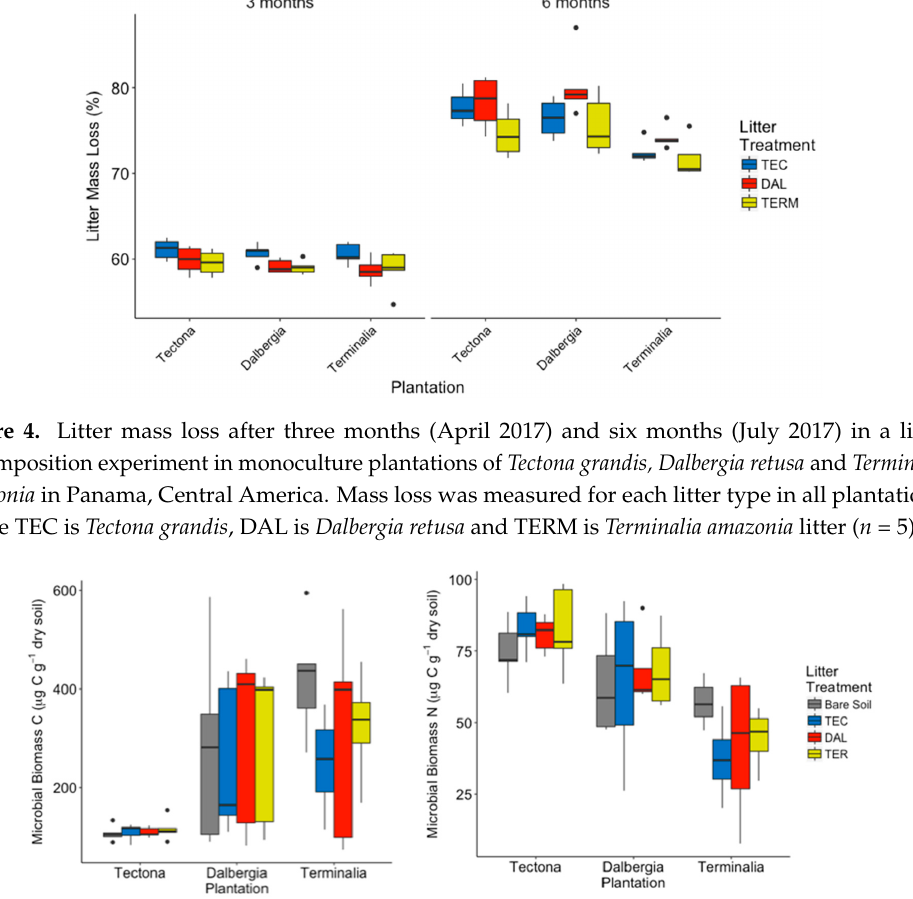
Figure 5. Soil microbial biomass carbon (C) ( a ) and nitrogen (N) ( b ) after six months (July 2017) in a litter decomposition experiment in monoculture plantations of Tectona grandis, Dalbergia retusa and Terminalia amazonia in Panama, Central America. Mass loss was measured for each litter type in all plantations, where TEC is Tectona grandis , DAL is Dalbergia retusa and TERM is Terminalia amazonia litter ( n =